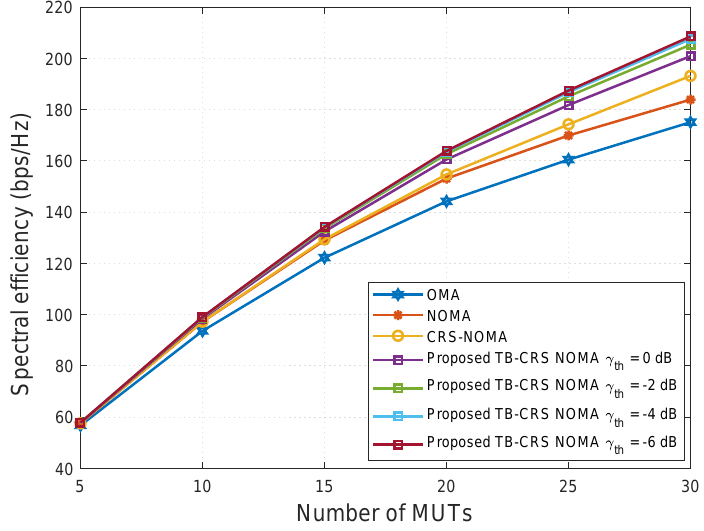
Figure 5. Spectral efficiency versus the number of MUTs when SNR = 20 dB. Figure 6 shows the spectral efficiency versus SNR when the number of MUTs served by the gNB is K = 32 and the SINR threshold is γ th = − 2 dB [50]. It is clear from Figure 6 that the proposed threshold-based user-assisted CRS beamspace mMIMO NOMA system achieves higher spectral efficiency than all the baseline systems. The proposed scheme shows a gain of approximately 15 bps/Hz at SNR = 10 dB compared with the CRS